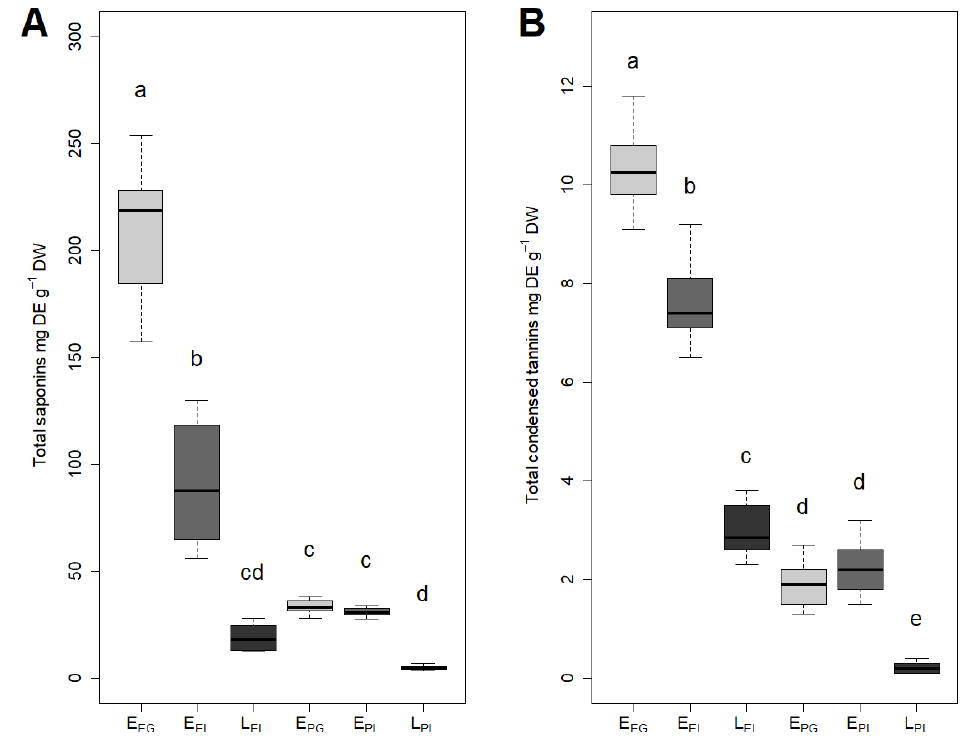
Figure 4. ( A ) Content of total saponin, expressed as mg of Diosgenin Equivalent (DE) g − 1 DW, ( B ) content of total condensed tannins, expressed as mg of Catechin Equivalent (CE) g − 1 DW, in Eucalyptus spp. and P. undulatum extracts and leachates (i.e., E EG = Extract of Eucalyptus spp. Green leaves; E EL = Extract of Eucalyptus spp. Litter; L EL = Leachate of Eucalyptus spp. Litter; E PG = Extract of P. undulatum Green leaves; E PL = Extract of P. undulatum Litter; L PL = Leachate of P. undulatum Litter). Each value is the mean of three measurements ± SD. Bars with the same letter are not significantly different when analysed by a one-way non-parametric analysis of variance (Kruskal– Wallis Test) followed by a Dunn’s Multiple Comparison post-hoc test.